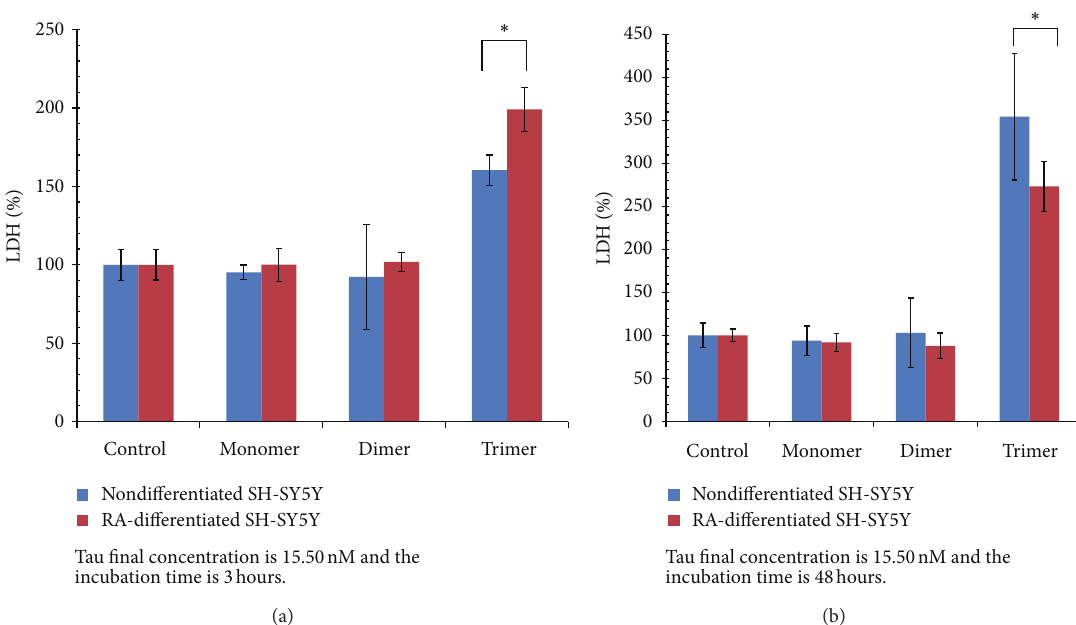
Figure 7: Comparison of rhTauinduced neurotoxicity toward nondifferentiated SH-SY5Y cells and retinoic-acid- (RA-) differentiated SH- SY5Y cells. The data combine toxicity results of 15.5 nM monomeric, dimeric, and trimeric forms of both 1N4R and 2N4R tau variants. (a) After 3 hours-incubation, RA-differentiated SH-SY5Y cells are more vulnerable to extracellular trimeric rhTau toxicity than nondifferentiated SHSY-5Y cells are ( 𝑃 < 0.05 ). (b) After 48-hours incubation, nondifferentiated SH-SY5Y cells are more vulnerable to extracellular trimeric rhTau toxicity than RA-differentiated SH-SY5Y cells ( 𝑃 < 0.05